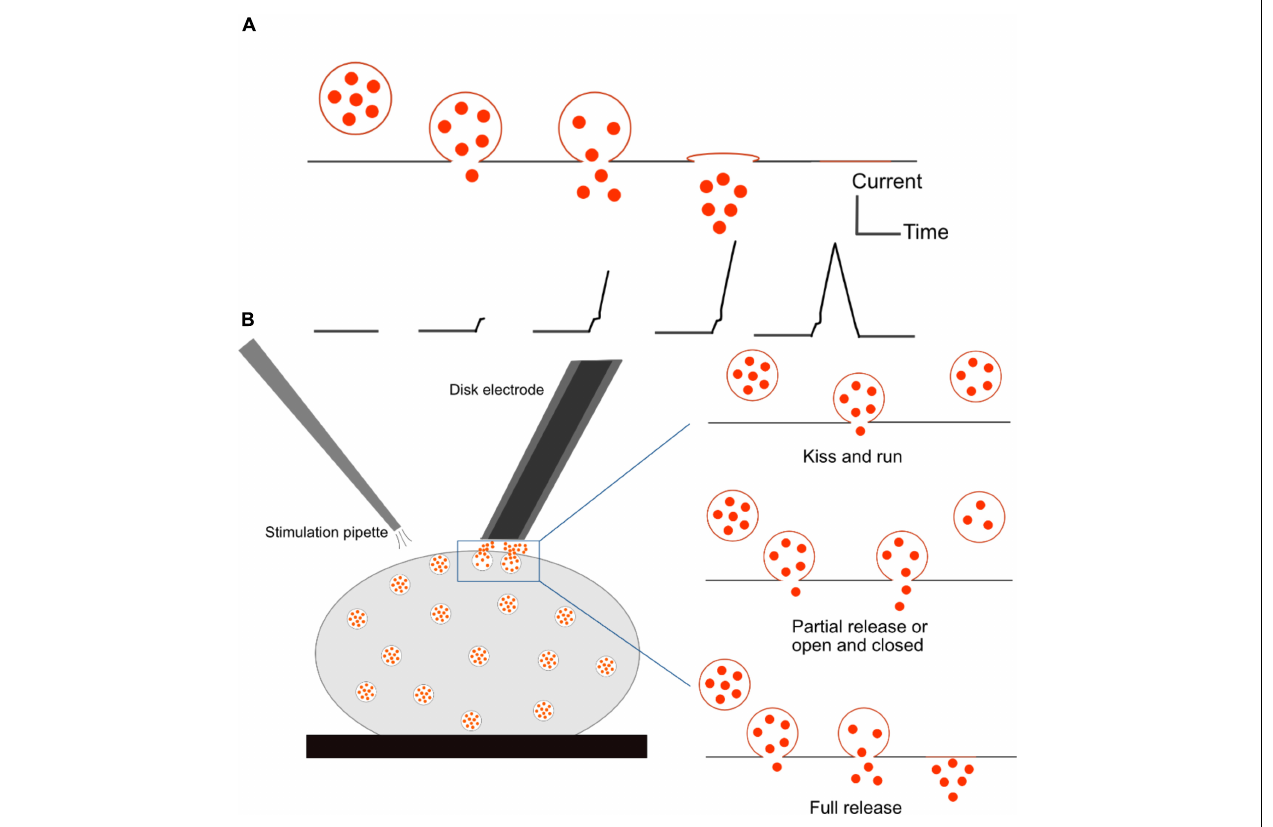
FIGURE 5 | Schematic of single cell amperometry (SCA) measurement and different modes of exocytosis. (A) Correlation of an exocytosis event of its recorded spike. (B) Schematic of disk electrode placement onto a cell and a stimulation pipette to initiate exocytosis (Left), and three different modes of exocytosis: kiss and run and partial release allow for a small fraction of neurotransmitters to be released from the vesicle, while full release expels all the transmitters (Right). The fraction of released transmitter is smaller in the kiss-and-run mode than in the partial release